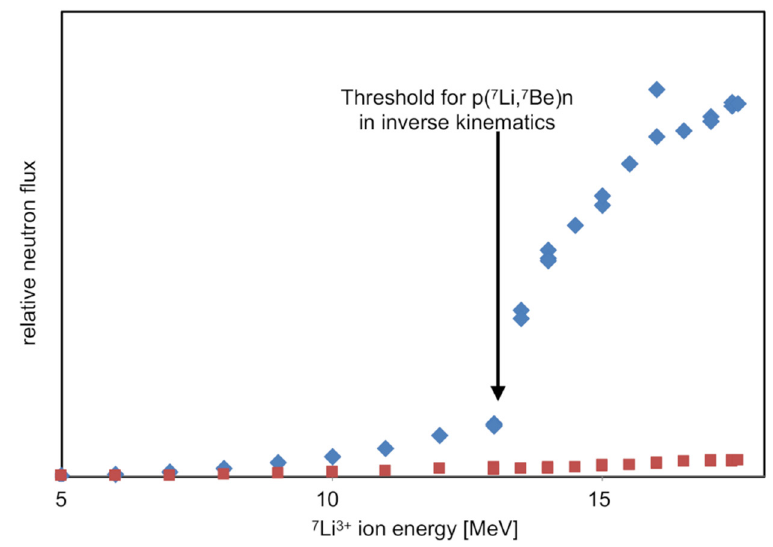
Figure 15. Results of the first commissioning experiments of the DANUBE neutron beam. The blue points show the current-normalized relative yield of neutrons in the forward direction, while the red points show the same yield but for 90° from the beam axis.